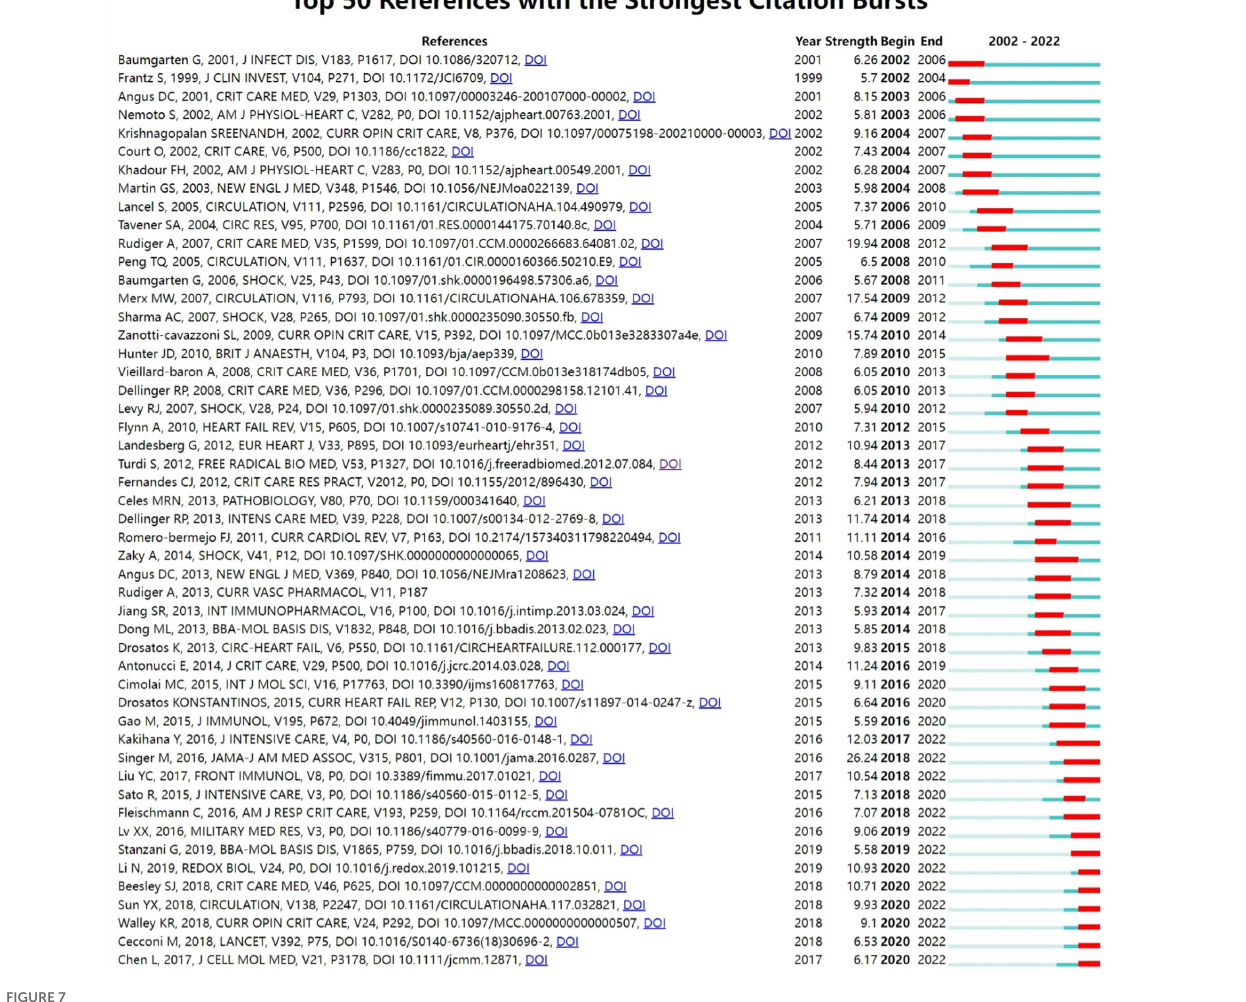
FIGURE7 CiteSpace visualization map of top fifty references with the strongest citation bursts related to SIMD.